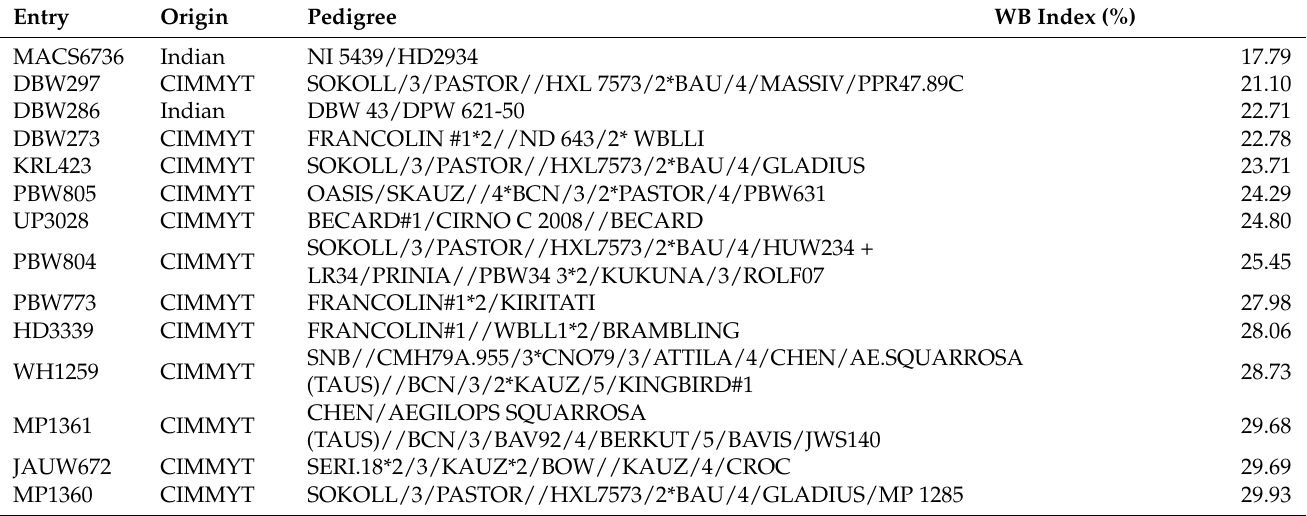
Table 4. List of non-2NS genotypes showing moderate resistance to wheat